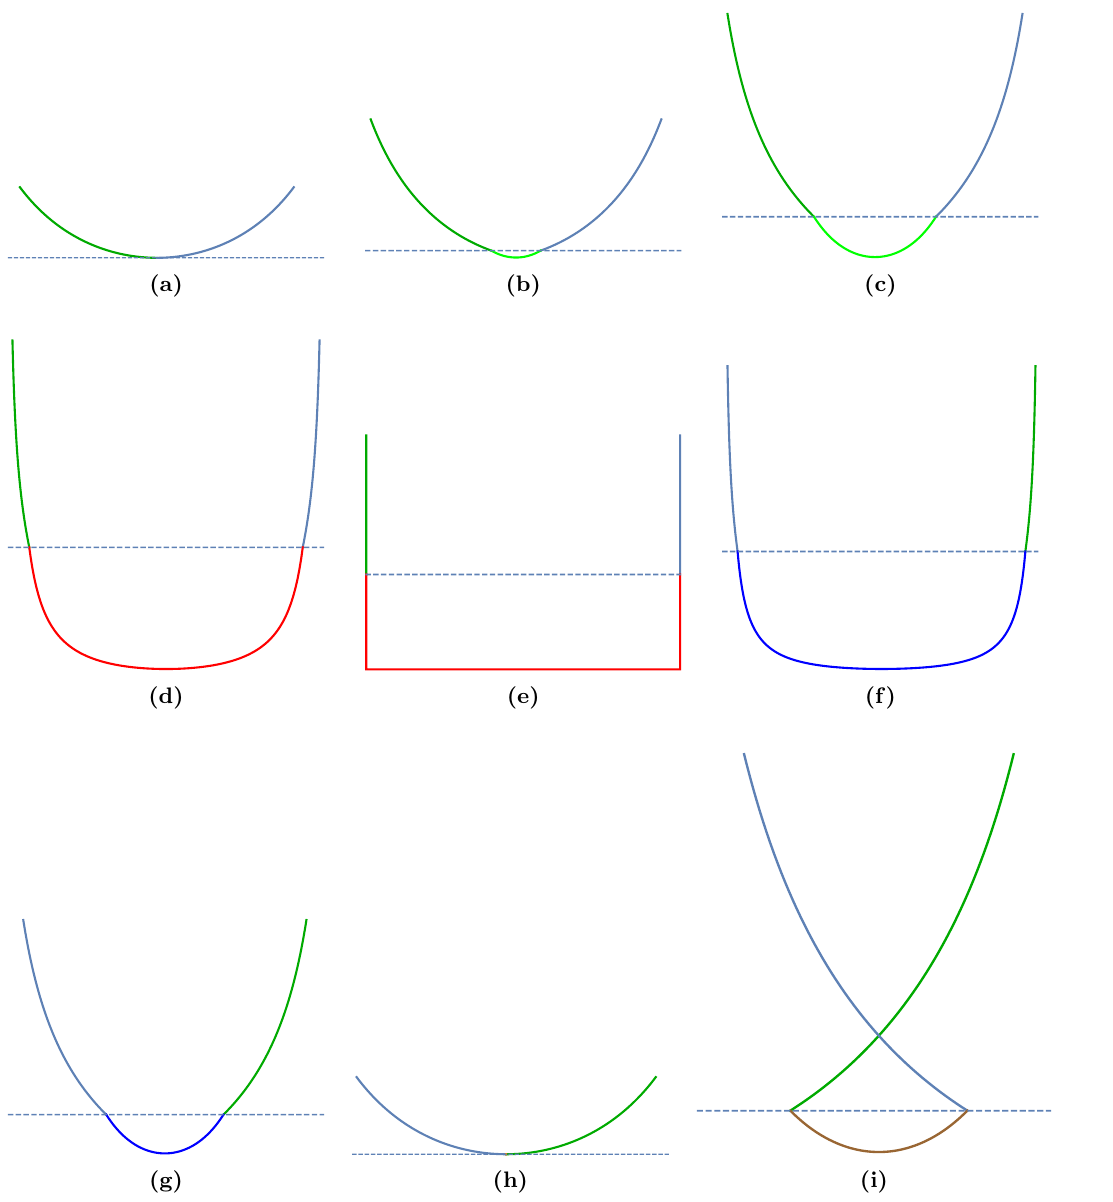
deeper into the shell ((cid:12)gure 12d), until we reach the minimum of (cid:0) (cid:1) s where (cid:1) X and Q = 0 ((cid:12)gure 12e). This brings us to the end of the red line. + Then the geodesic starts penetrating the shell less and less (blue line and (cid:12)gure 12f). We observe that after the point where (cid:1) X